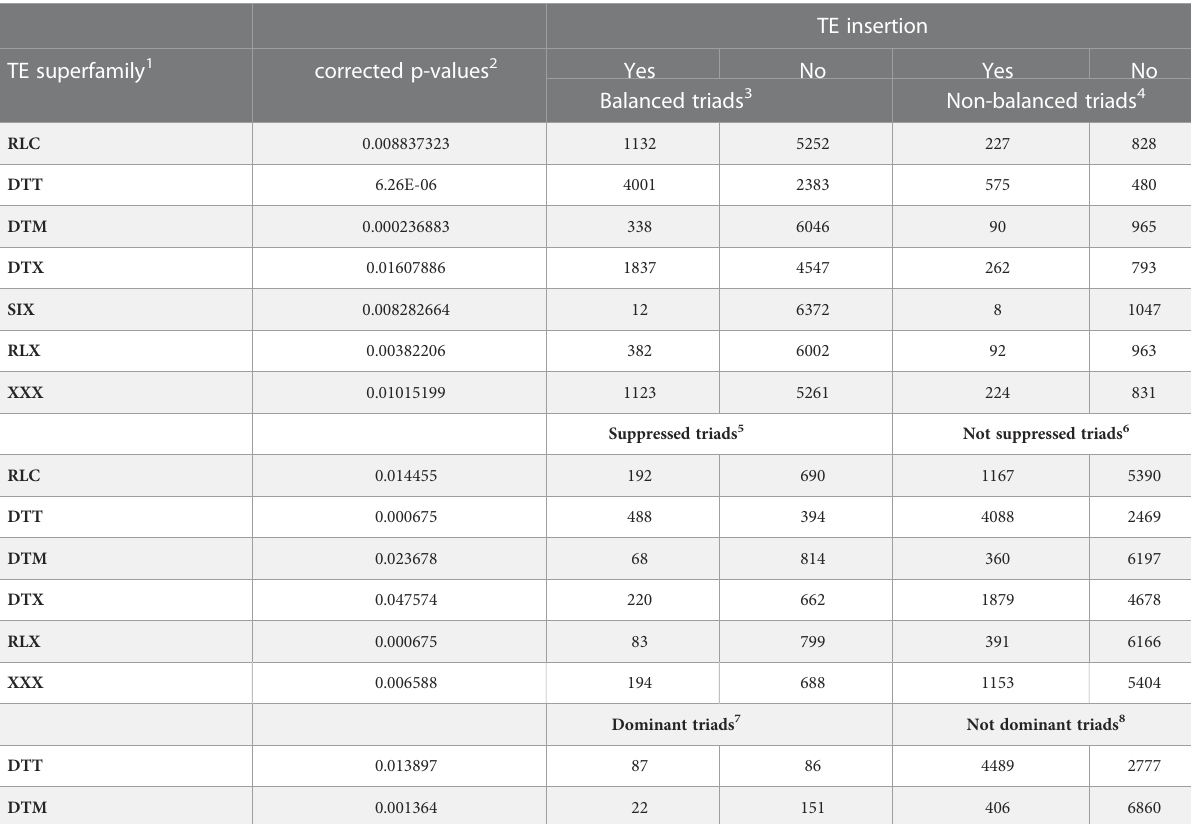
TABLE 2 TE superfamilies for which the presence\absence of TE insertion in at least one of the triad genes correlated with speci fi c triad expression